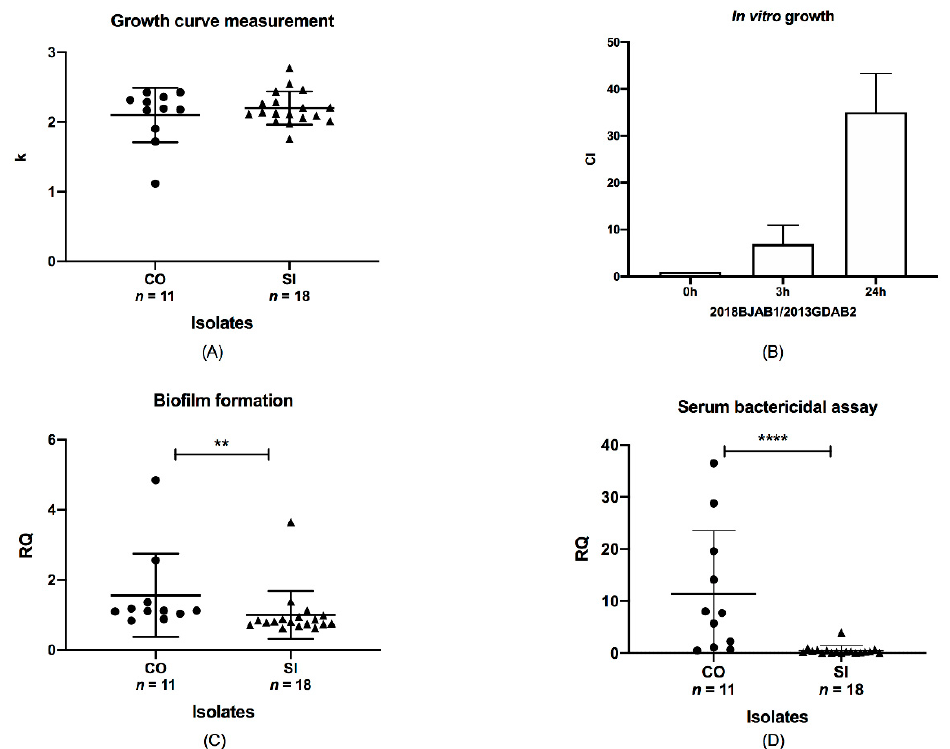
Figure 3. Relationship between phenotype discrepancies and bla OXA-23 location. Data were analyzed using the Mann–Whitney test, p < 0.05. ( A ) Analysis of the growth of CO and SI isolates. The ordinate represented the corrected k value. ( B ) Competition indices of CO and SI isolates at 0, 3, and 24 h. 2018BJAB1, CO isolates; 2013GDAB2, SI isolate. ( C ) Biofilm formation by CO and SI isolates. Two asterisks (**) indicated a significant difference ( p < 0.01). The ordinate represented the corrected adhesion unit. ( D ) Serum resistance of CO and SI isolates were shown by the survival of all isolates after incubation in normal human serum. Four asterisks (****) indicated a significant difference ( p < 0.0001). The dots represented CO isolates and the triangles represented SI isolates.